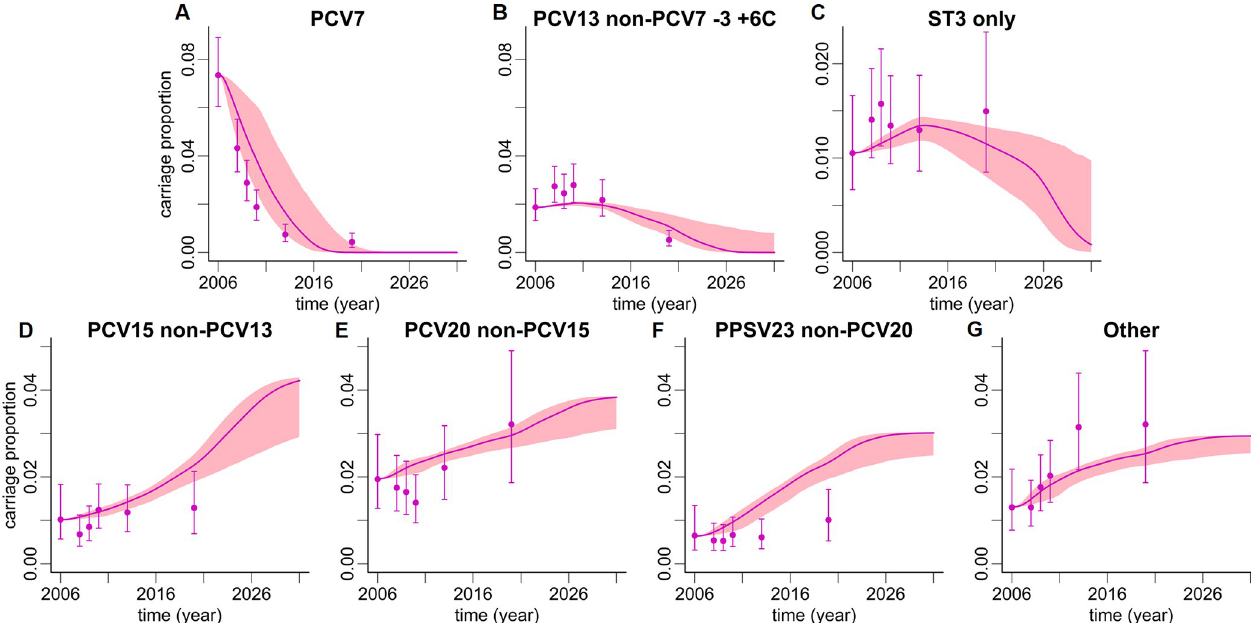
Fig 5. Predictions of vaccination model for adults aged 60-74y. Shown are vaccine serotype groups (upper row) PCV7 (A), PCV13 non-PCV7–3 +6C (B), serotype 3 (C), and non-vaccine serotype groups (lower row) PCV15 non-PCV13 (D), PCV20 non-PCV15 (E), PPSV23 non-PCV20 (F), and Other (G). Data points (pneumococcal carriage proportions regarding to all individuals of the age group in Germany, including non-carriers) are shown as filled circles with 95% CIs. Data points were calculated from adjusted IPD incidence rates via case-carrier ratios. Lines with shaded 95% prediction intervals depict simulation results.